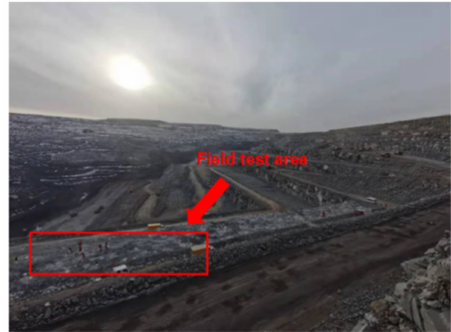
Figure 2. Schematic diagram of test